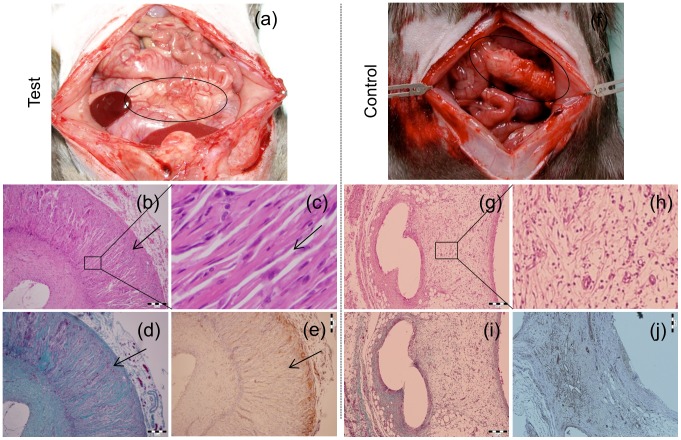

In vivo behavior of the test (a–e) and control (f–j) scaffolds.(a, f) 4-week old anastomosed scaffolds as seen in the omentum of the model animal; (b, g) low magnification and (c, h) high magnification H&E stained sections showing the host cell infiltration and cell distribution (deep blue-purple nuclei, pink cytoplasmic and extracellular proteins); (d, i) TRI stained sections showing the synthesis of extracellular collagen (blue or green) by the invading cells; and (e, j) anti-CD31 stained sections showing the infiltration of microvascular endothelial cells (brown). The black arrow in the panels (b–e) represents the direction of host cell/tissue infiltration. Scale: 200 µm.